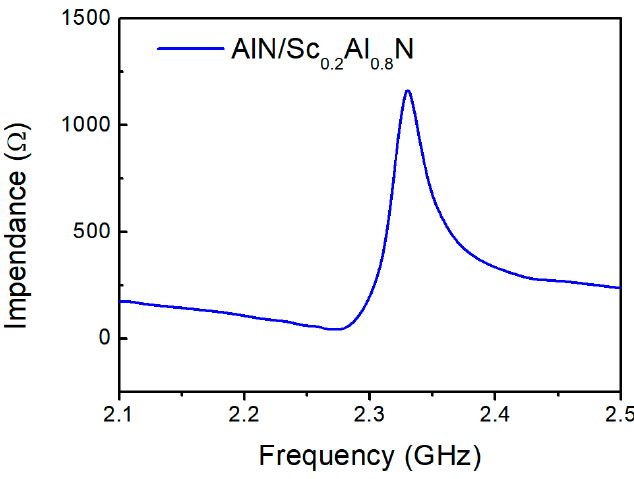
Figure 7. The impedance curve of fabricated lamb wave resonator based on AlN/Sc 0.2 Al 0.8 N composite film. Table 2. Comparison of previous work with K eff2 .